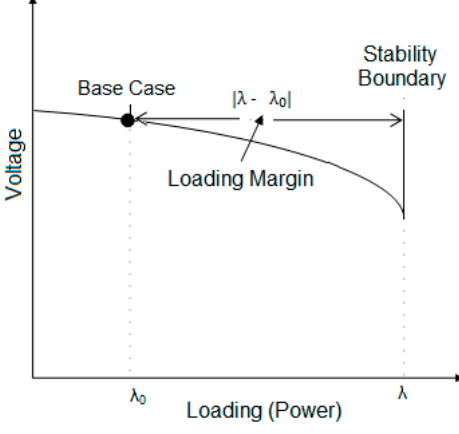
Figure 1. Definition of loading margin.